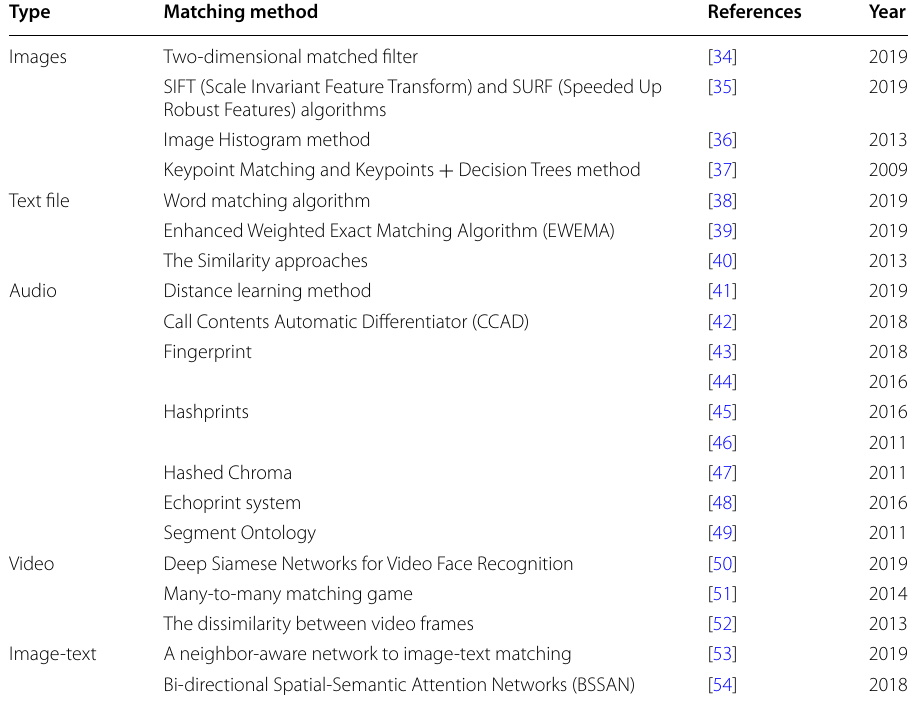
Table 1 Different methods for matching